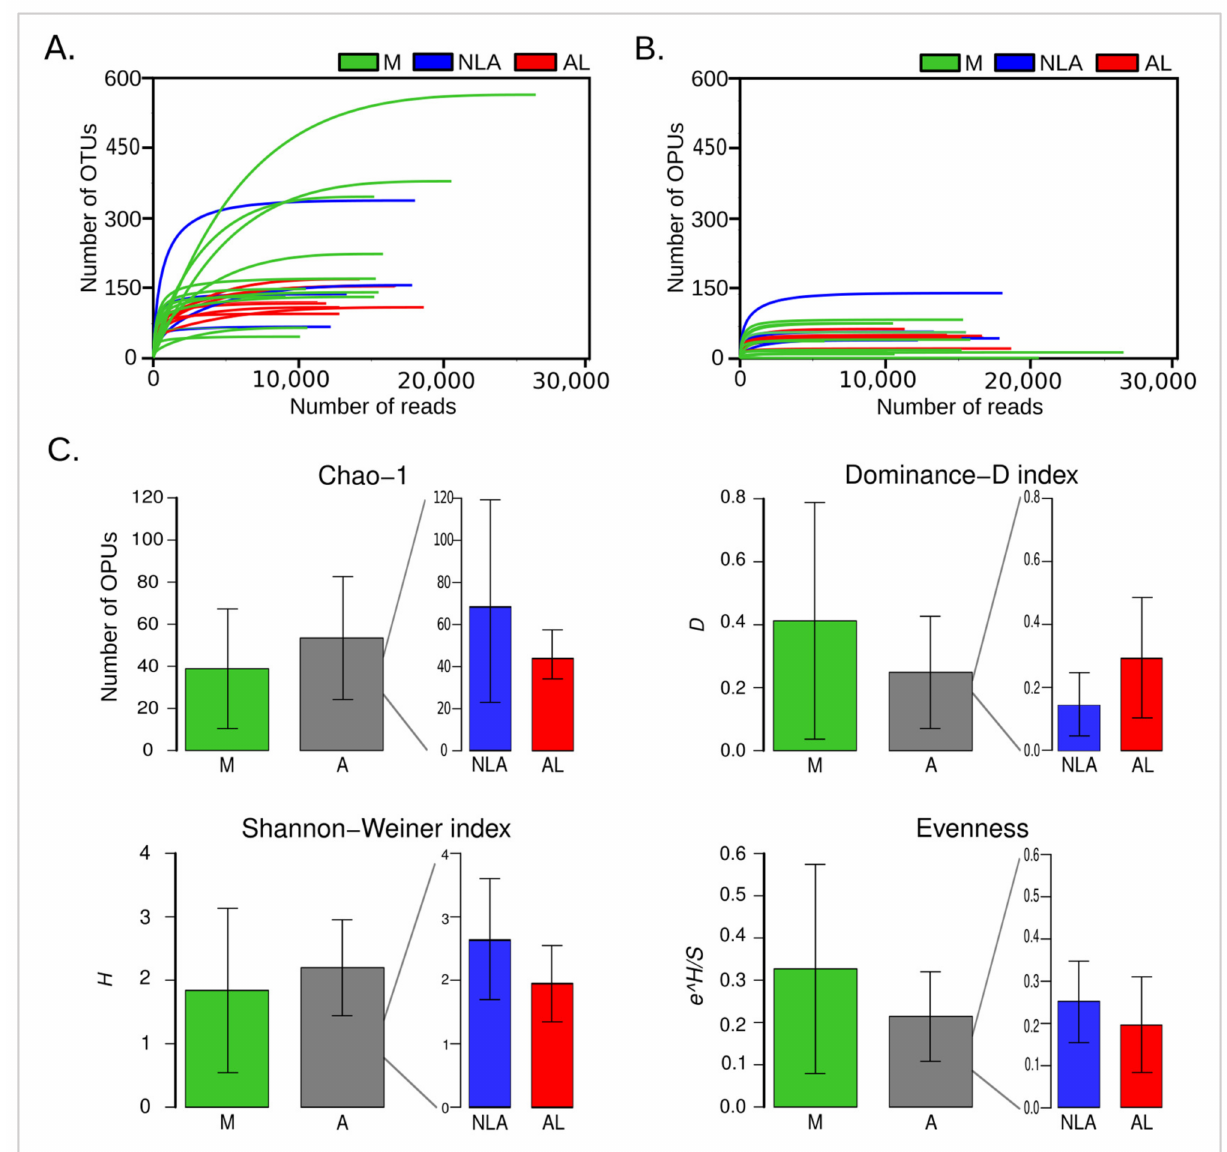
Figure 2. Rarefaction and alpha diversity. Rarefaction curves for detected OTUs ( A ) and OPUs ( B ), where each line represents an independent sample. ( C ) Alpha diversity indices, where the average diversity index ± standard deviation for each group is plotted. The Wilcoxon rank sum test was used to compare differences (* p < 0.05) between groups. M: control mucosa group, A: experimental anastomosis group, NLA: non-leak anastomosis, AL: anastomotic